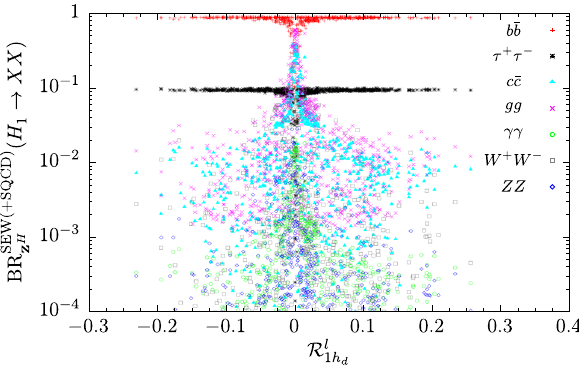
Fig. 1 Scan1: Loop-corrected branching ratios of the lightest Higgs boson, which is the singlet-like state, into SM particles versus the ele- ment R l of the loop-corrected Higgs rotation 1 h d